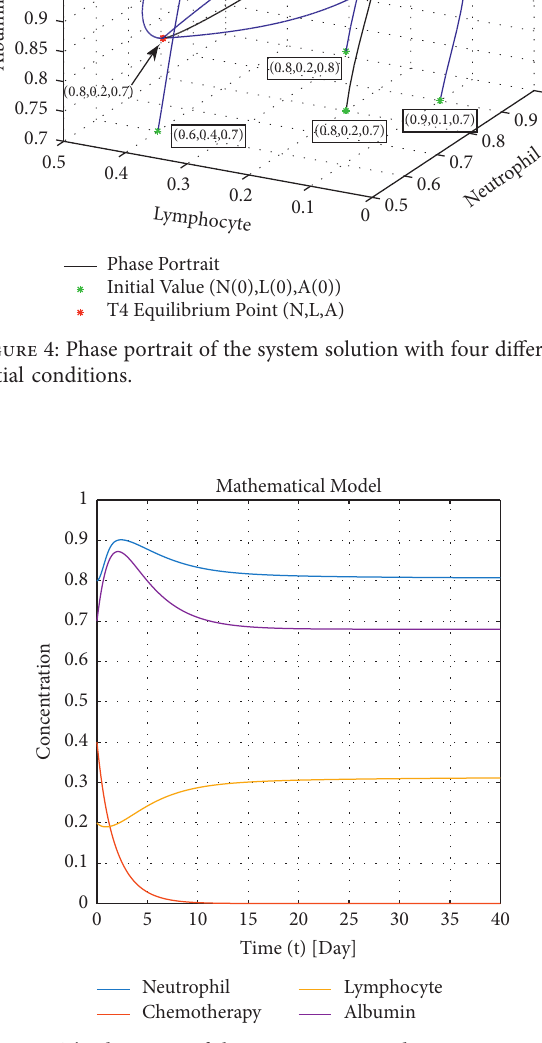
Figure 5: The dynamics of change in N, C, L, and A over time in the second